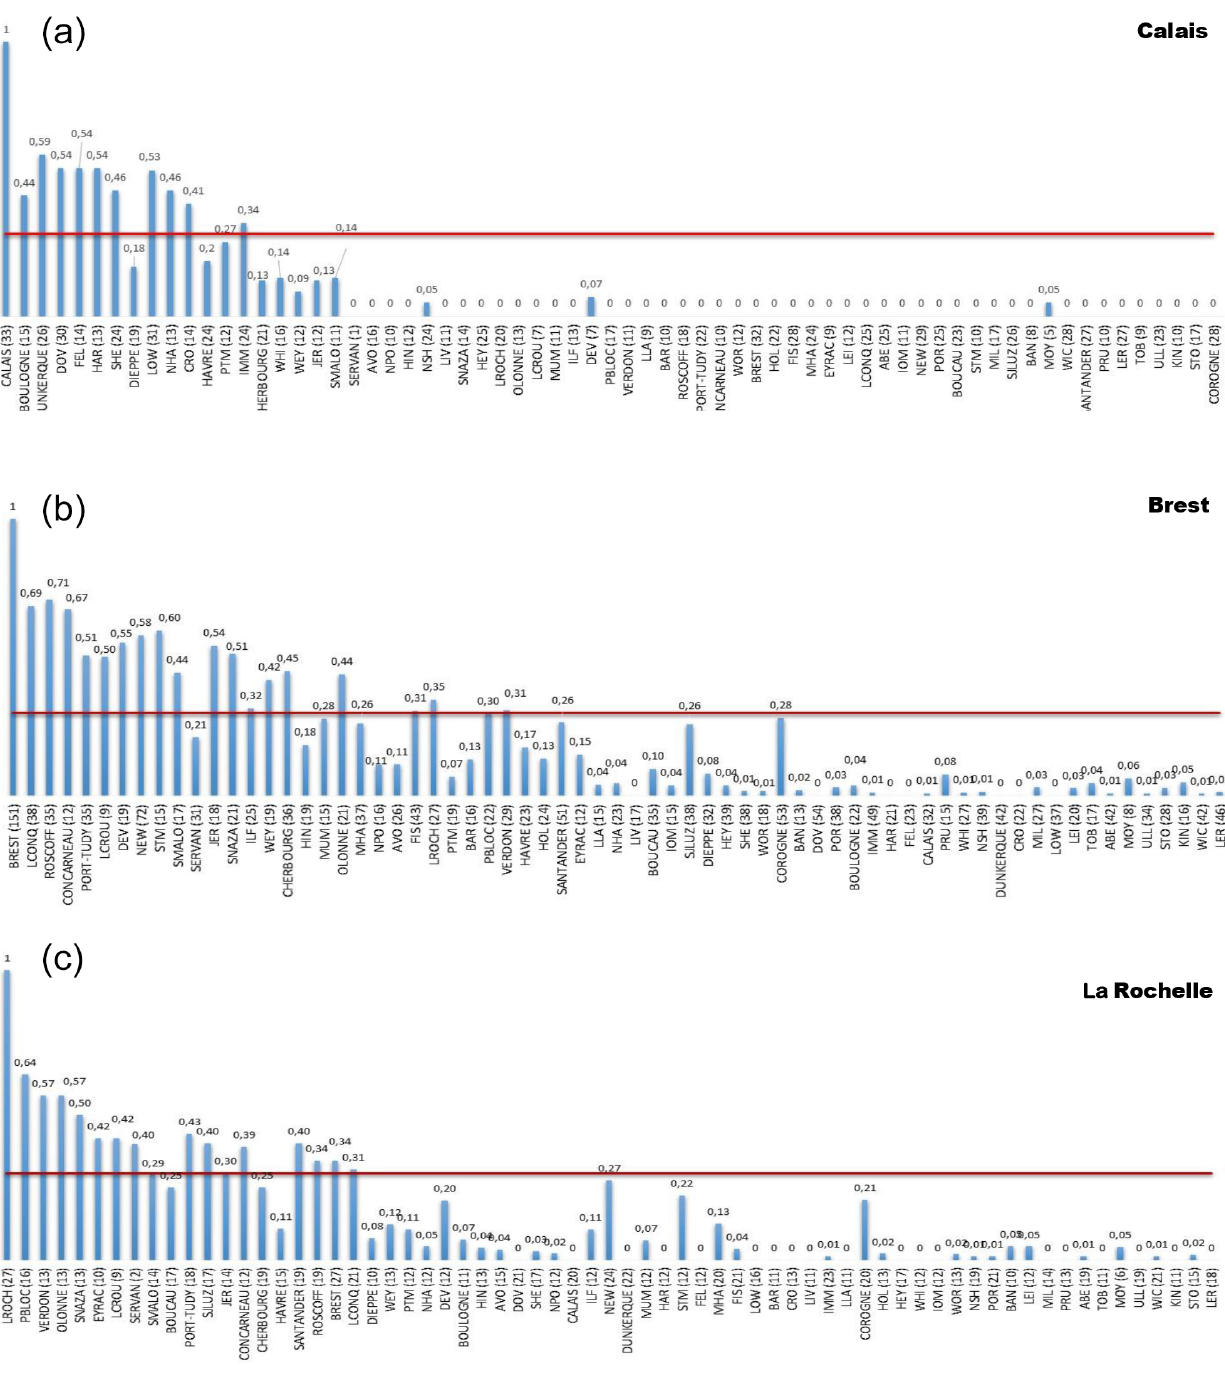
Figure 4. The ESE for Calais (a) , Brest (b) , and La Rochelle (c) . The abbreviations of the horizontal axis are presented in Fig. 2. The vertical blue bars have lengths proportional to the extremogram values. The value of each extremogram is indicated above the blue bars. The red line represents the threshold (equal to 0.3) above which the extremogram value is large enough that the associated site can be considered to belong to the same region as the target site. The overlap period (in years) of the observation periods of each site with that of the target site is indicated in the brackets next to each site